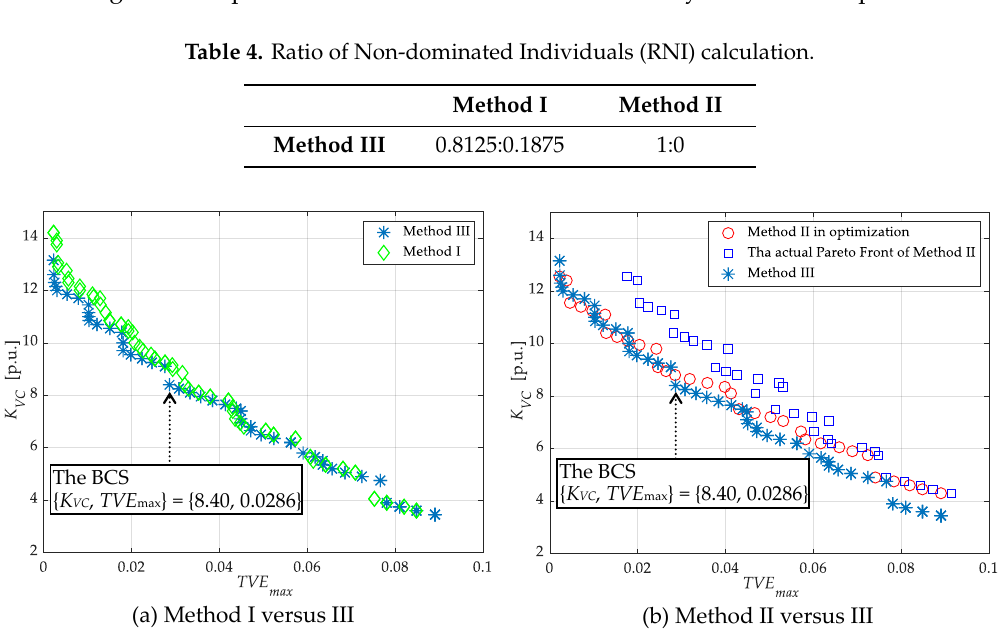
Figure 4. Obtained Pareto fronts in each method.